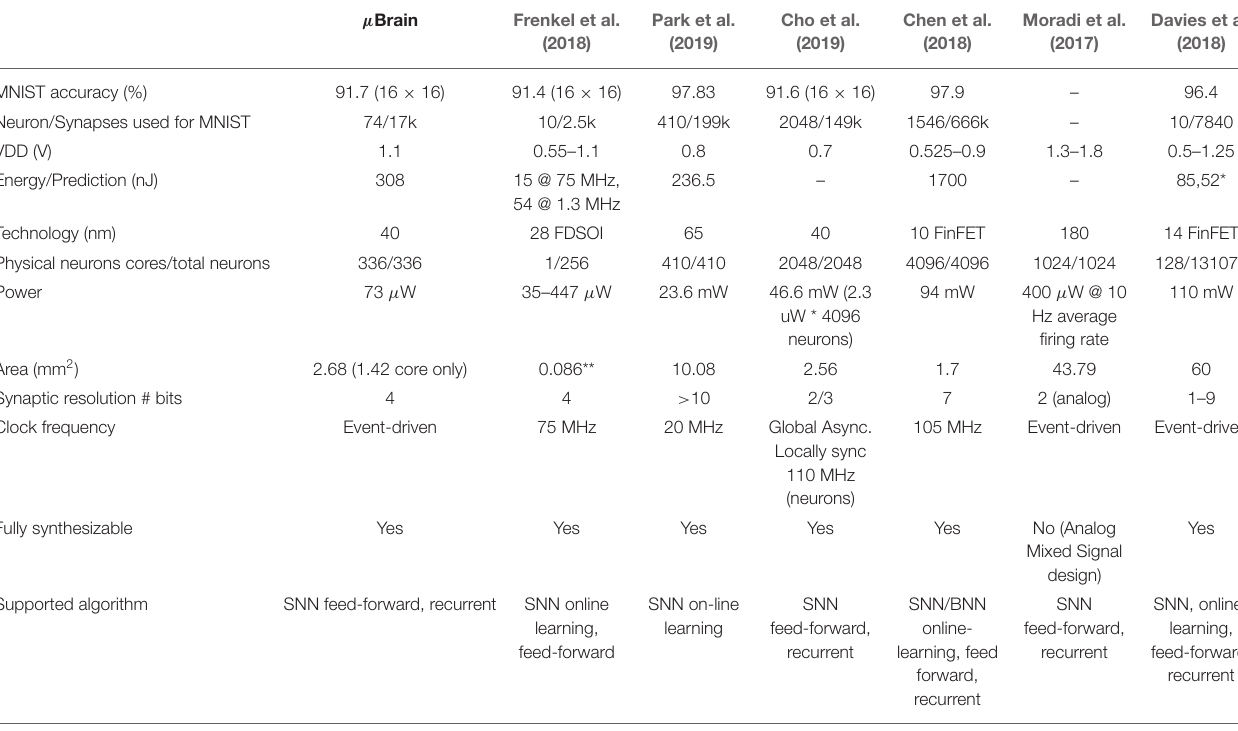
TABLE 2 | Reference comparison of µ Brain with other neuromorphic processors for the MNIST handwrittend digit